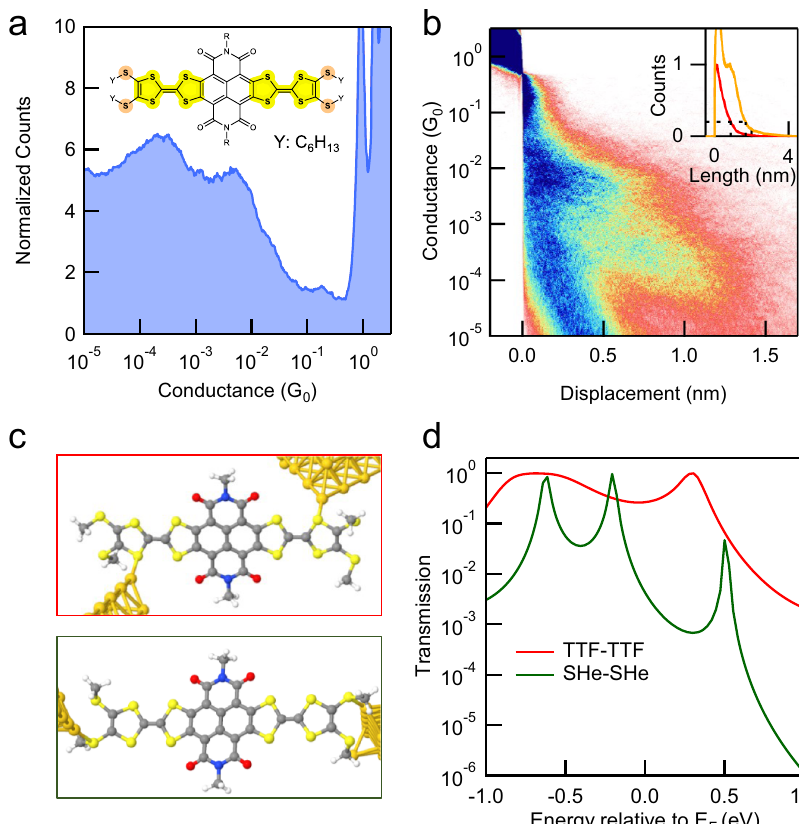
Fig. 4 Charge transport properties of NDITTF-SHe. a Logarithm-binned 1D histograms for NDITTF-SHe at an applied bias of 0.5 V. Inset: Molecular structure of NDITTF-SHe. b 2D conductance-displacement histograms for NDITTF-SHe at an applied bias of 0.5 V. All histograms are compiled from 10,000 traces without data selection. Inset: Normalized length pro fi les determined from the 2D histogram. c Junction structures with different binding sites used to compute the junction transmission functions. d Transmission functions against energy of the two types of